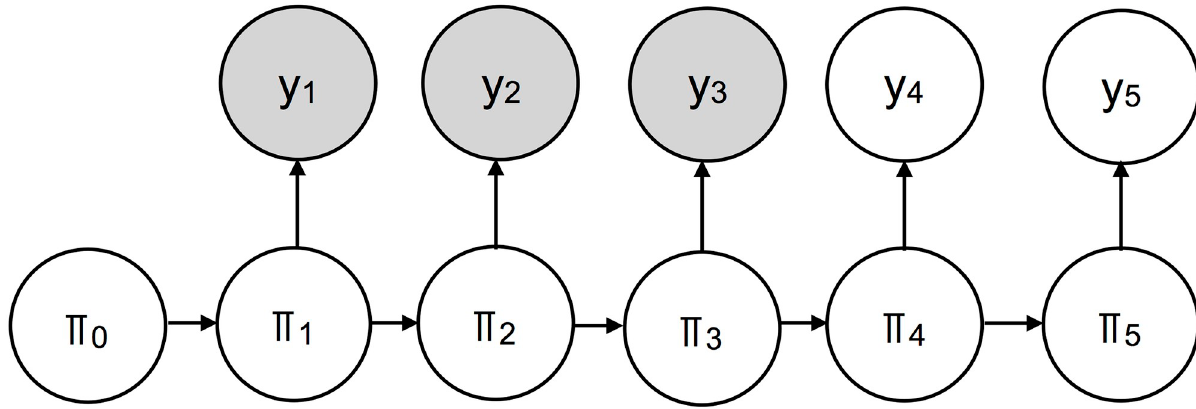
Fig 4. A simplified graphical representation of DBM. π observed quantities; unshaded nodes represent unobserved quantities. Directed edges represent dependencies between nodes.